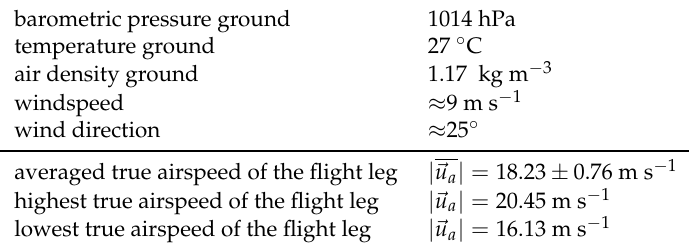
Figure 14. Top view with one leg in the wake of the Enercon E-112 prototype wind turbine with the horizontal windspeed ( v h ) in the color code. The light direction was from west to east. The schematic turning direction of detaching tip vortices in a horizontal plane through the rotor center is sketched. The positions of the tip vortices of the measurement are indicated with arrows. The depicted wind turbine is an appended schematic model, indicating the azimuth-angle of the nacelle during the measurement. Table 4. Overview of the conditions during the WAKE